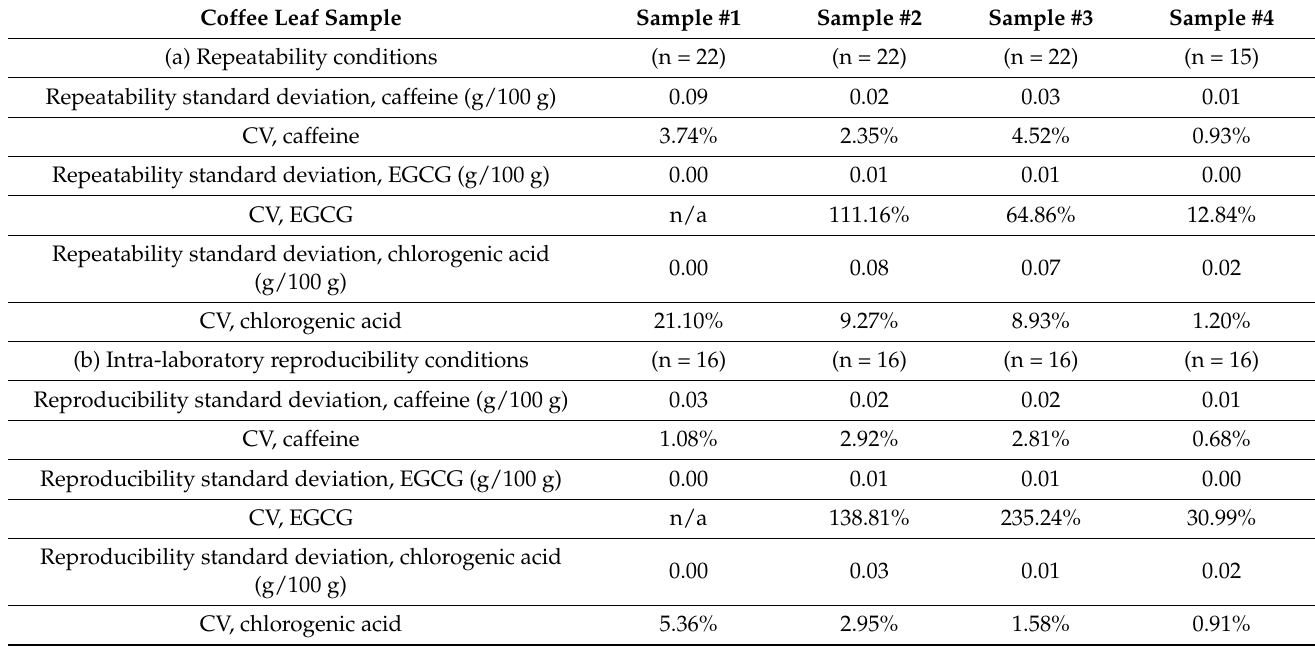
Table 1. Precision of HPLC measurement of 4 samples of coffee